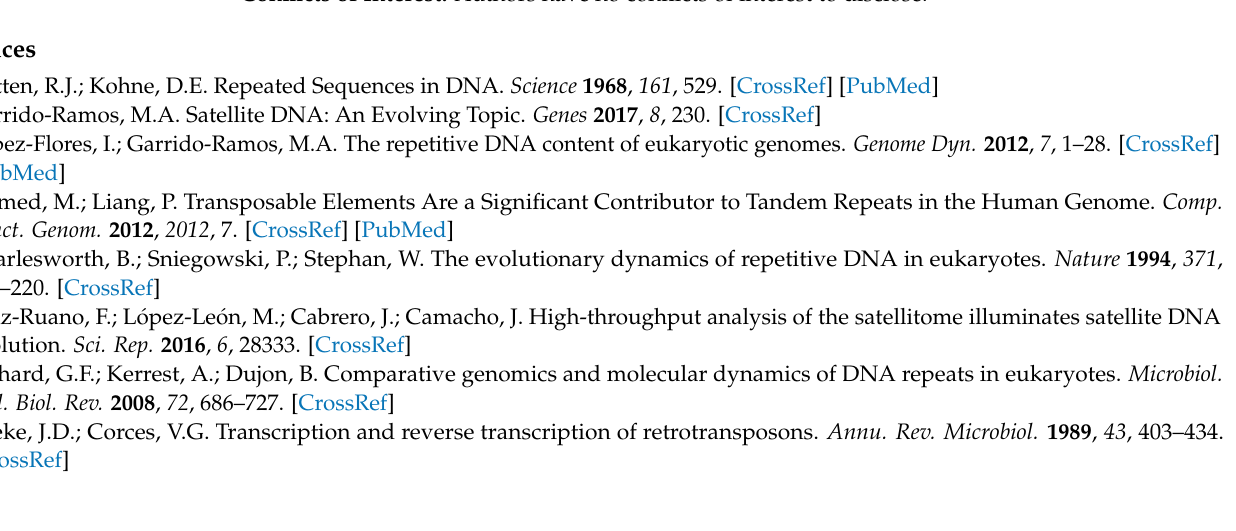
single-peak and flattened distribution of abundance against the divergence, Figure S6: Satellitome graphical-structures for each family of satDNAs. The comparative graphical structures of satellite DNAs and rDNA-repeats reported in the Repeatexplorer2 output. Colors in the graph represent the species-specific reads (green-for-italicus, blue-for-abbreviatus, and red-for-barbarus) where the node denotes a specific read and the edges as a bridge (connecting lines) between the similar reads, Figure S7: Interspresed repeat landscapes and line graphs of rDNAs and CSat20-45 family. The interspersed repeat landscape of rDNA-repeat, CSat20, and unclassified cluster has been shown here ( a ). In C. barbarus , a distinct individual repeat landscape demonstrates the existence of a single abundant peak of CSat20-245 satellite DNA. Similarly, the recent abundant copy of 5S-rDNA-01 in C. italicus and C. barbarus revealed one peak and multi-variant flat distribution in C. abbreviatus . There are two peaks of 5S-rDNA-02, the recent one and another ancient/degenerated highly divergent copy ( b ), Figure S8: The individual satellite DNAs repeat and variant profiles demonstrate the strong species-specific signatures. Species profiles arranged in a sequence of C. abbreviatus => C. barbarus => C. italicus . Most of the satDNAs profiles have shown reasonable read depth coverage with the decrease of variation in the variant profiles, which are represented in dark red color. The CSat12 profile uneven coverage of repeats with sharp boundaries shows the differential amplification of fragmented copies of this repeat, implying the novel spread of satellite DNA sequence. Additionally, some profiles suggest the residual existence of some of the satDNAs degenerated copies such as CSat12 profile in C. italicus